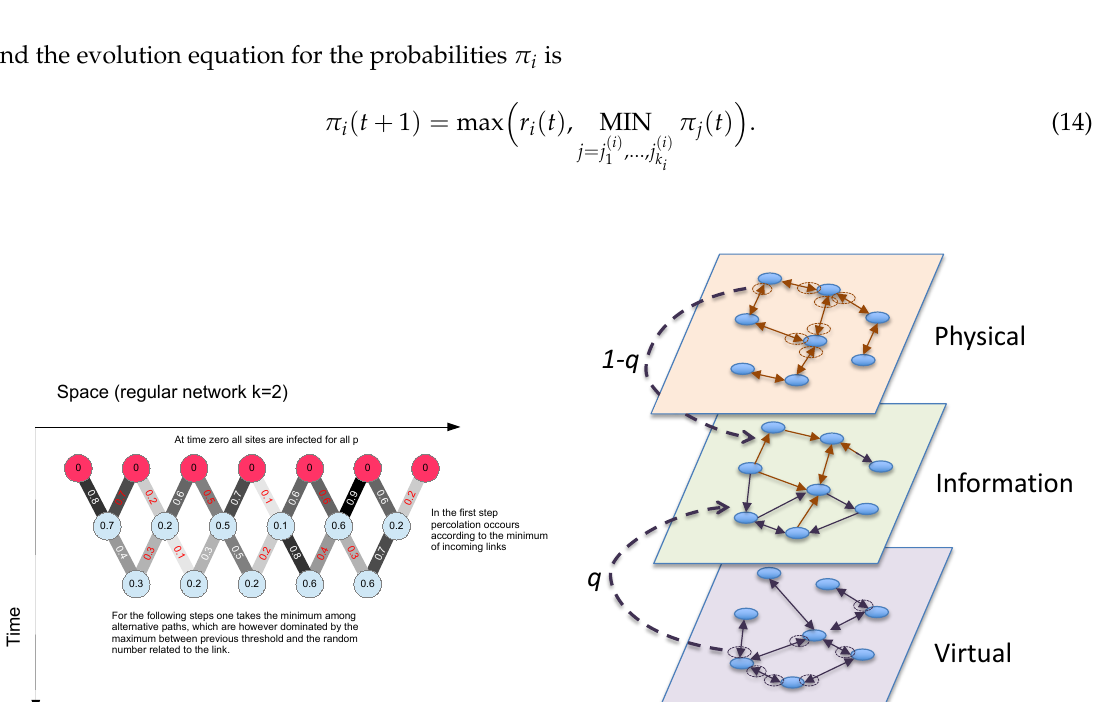
Figure 14. ( Left ) Evolution of the local minimum value of the percolation parameter p i for a 1D regular network with k = 2; and ( Right ) an example of multiplex generated with our method. We start with the physical and virtual networks, both symmetric and with the same average connectivity, and then we build the information network by choosing, for each node, outgoing links with probability q from q from the real one. Figures from the virtual network and with probability 1 −